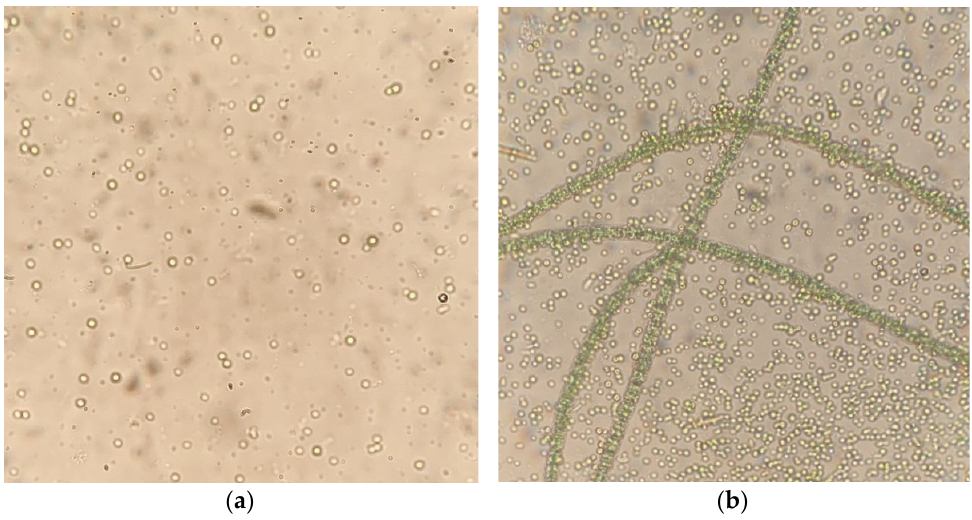
Figure 6. Images of the culture during the experiment with the initial CO 2 concentration of 9 vol.%. ( a ) 10th day of the experiment, ( b ) 15th day of the experiment (400 times magnification).